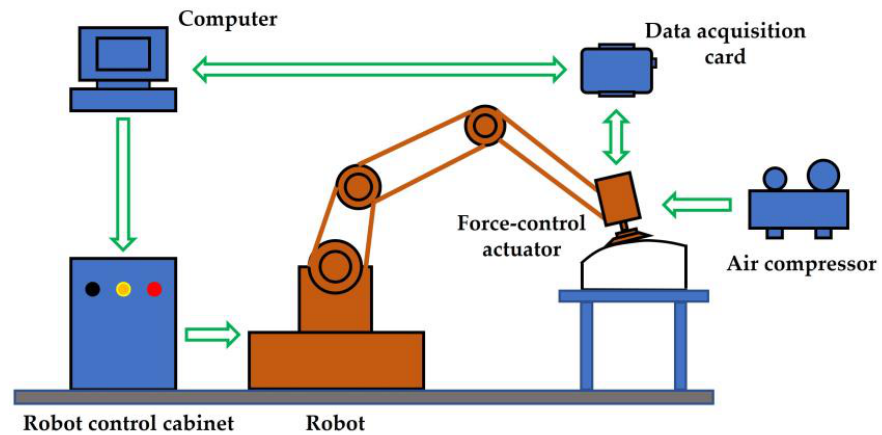
Figure 4. Robot automatic polishing system.